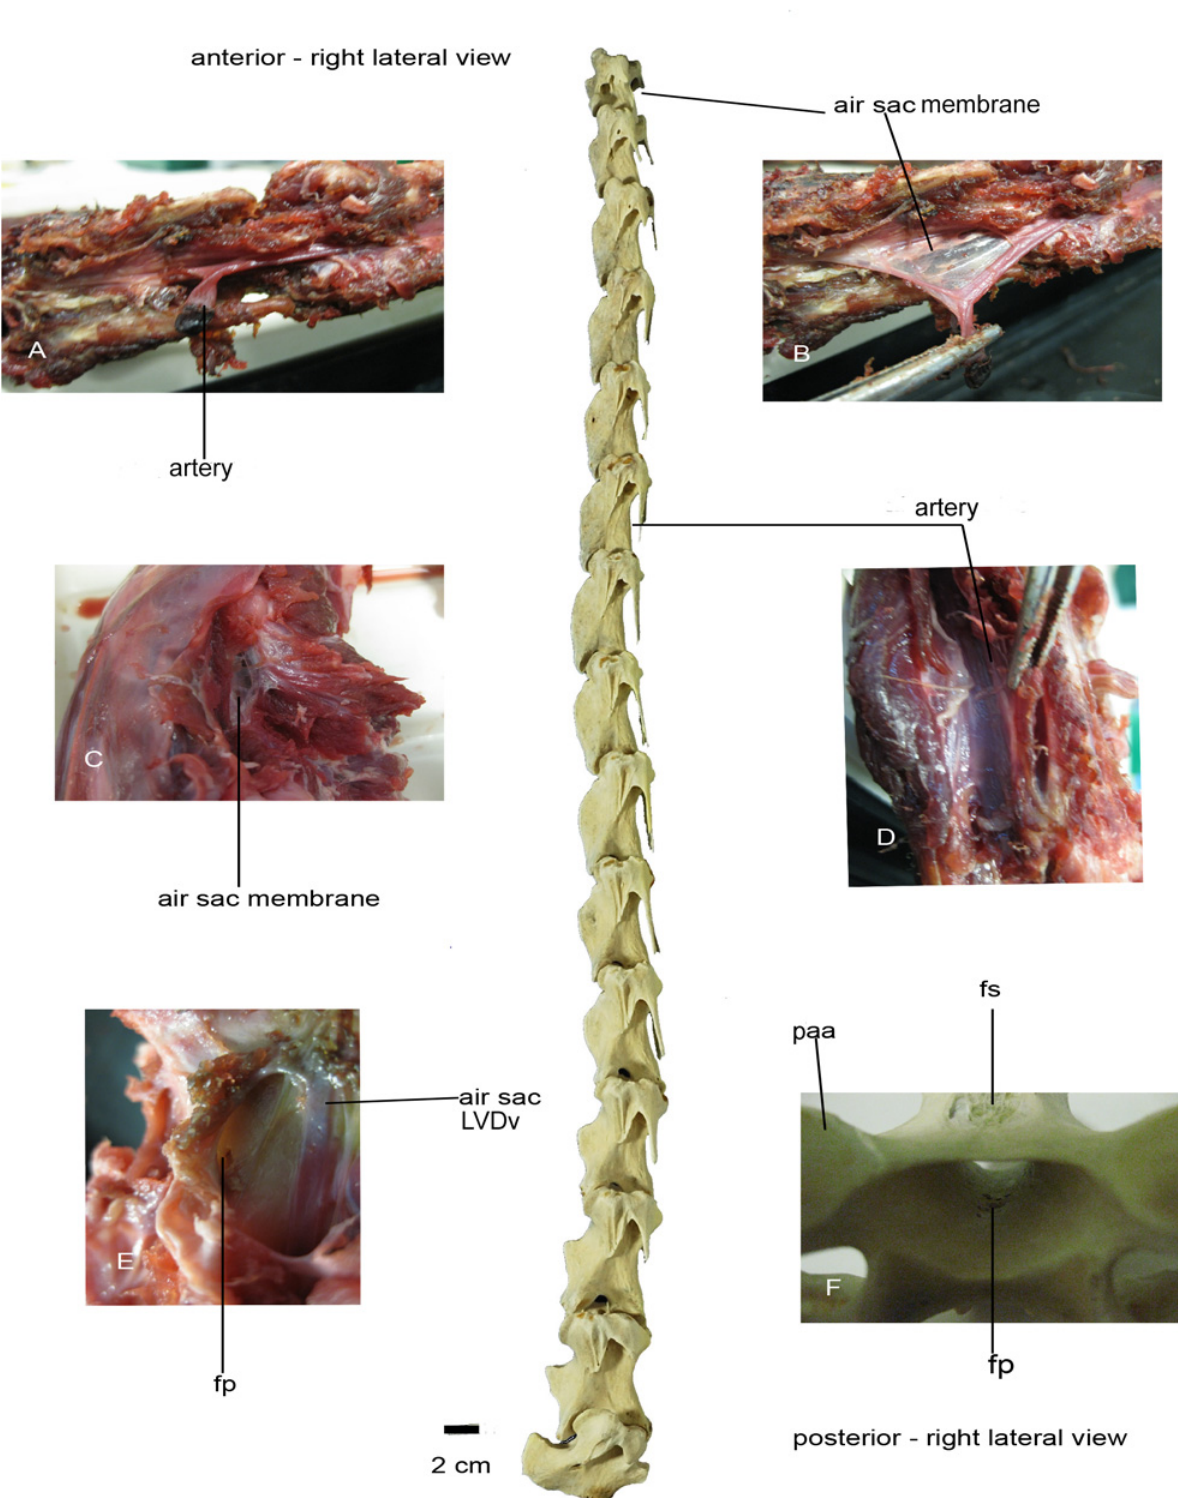
Fig 3. Right lateral view of the ostrich neck with flesh depictions. (A) Anterolateral view of the anterior part of the neck revealing the free end of the cervical artery; (B) Same for (a) but with the artery extended revealing its associated semi-transparent diverticular membrane that attaches within the muscle layers; (C) Partially dissected ostrich neck with some of the exterior muscle layers stretched out showing the intertwined air sac membranes; (D) Image